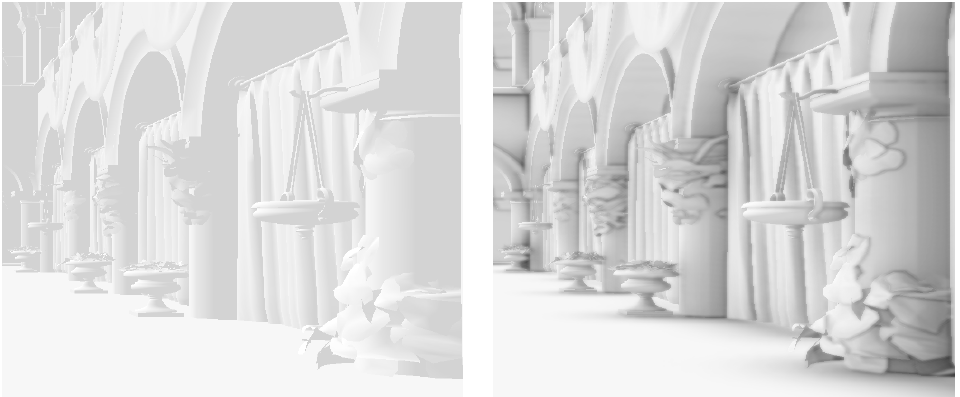
Figure 3. Visual comparison of a scene illuminated by ambient light. The image on the right shows how ambient occlusion estimation increases the realism of the scene. In particular, note that this method generates soft global shadows that contribute to the visual separation of